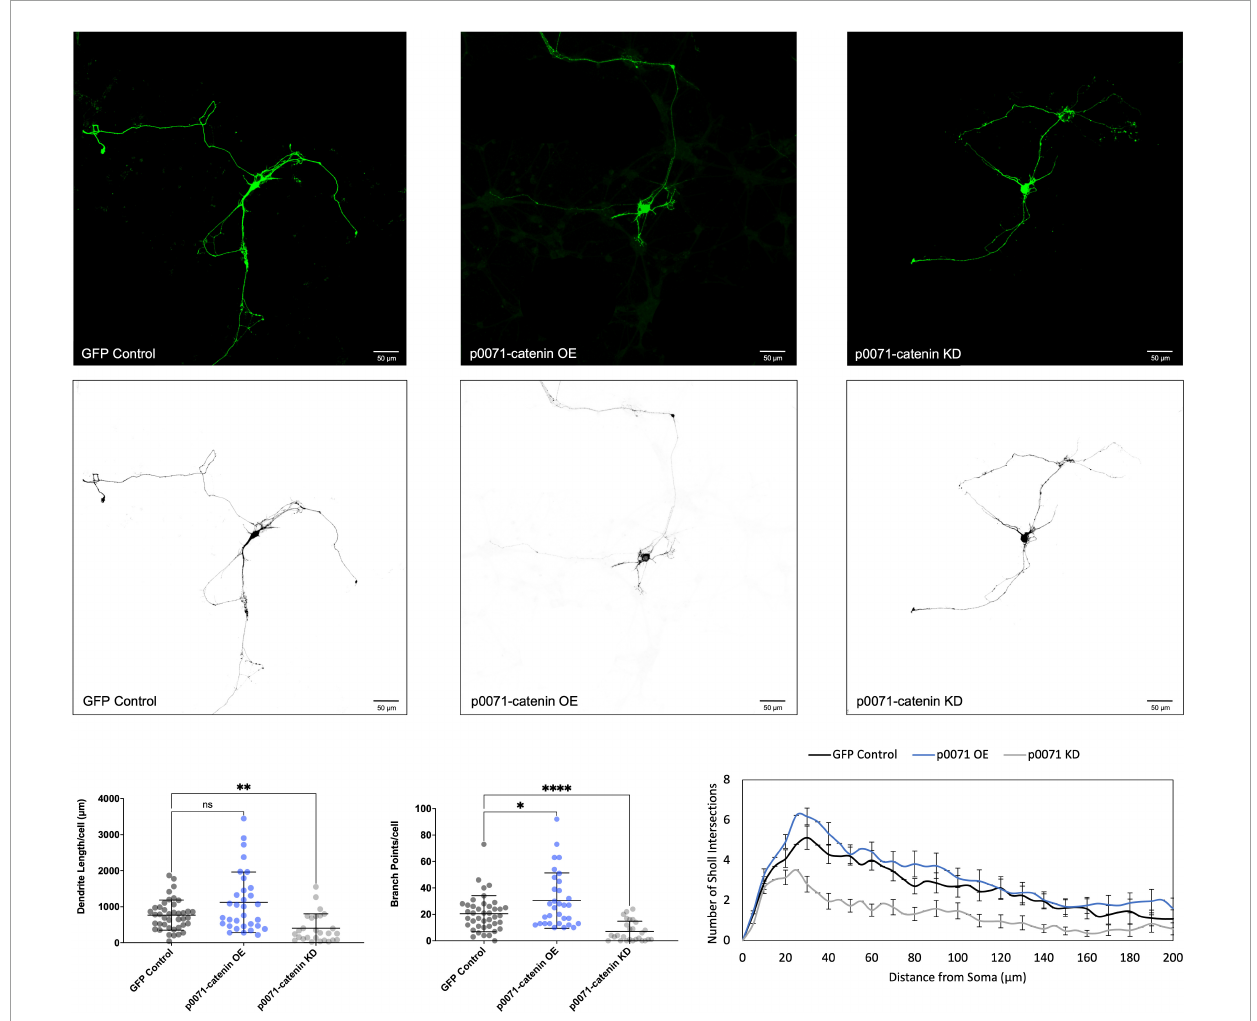
FIGURE6 Morphological effects of p0071-catenin expression in developing rat primary hippocampal neurons. Example images are shown of neurons that have been transfected with GFP, exogenous p0071-catenin, and shRNA to knockdown p0071-catenin. Cells were transfected at 3 DIV and analyzed at 7 DIV. These images have been masked to eliminate other cells in the visual field for clarity. Quantification of the average dendrite length per cell and average number of branch points per cell per each condition are shown below on the left, and Sholl analysis for each condition to the right. The number of cells analyzed in each condition were 32 for p0071-catenin OE, 27 for p0071-catenin KD, and 41 for GFP control. Samples were taken from five biological replicates. Statistical significance was determined using a two-way Brown-Forsythe and Welch ANOVA tests with Dunnett’s T3 multiple comparisons post-hoc test. Significance was assigned at P < 0.05 for *, P < 0.01 for **, P < 0.0001 for ****, and ns for non-significant. Chart values show mean and standard